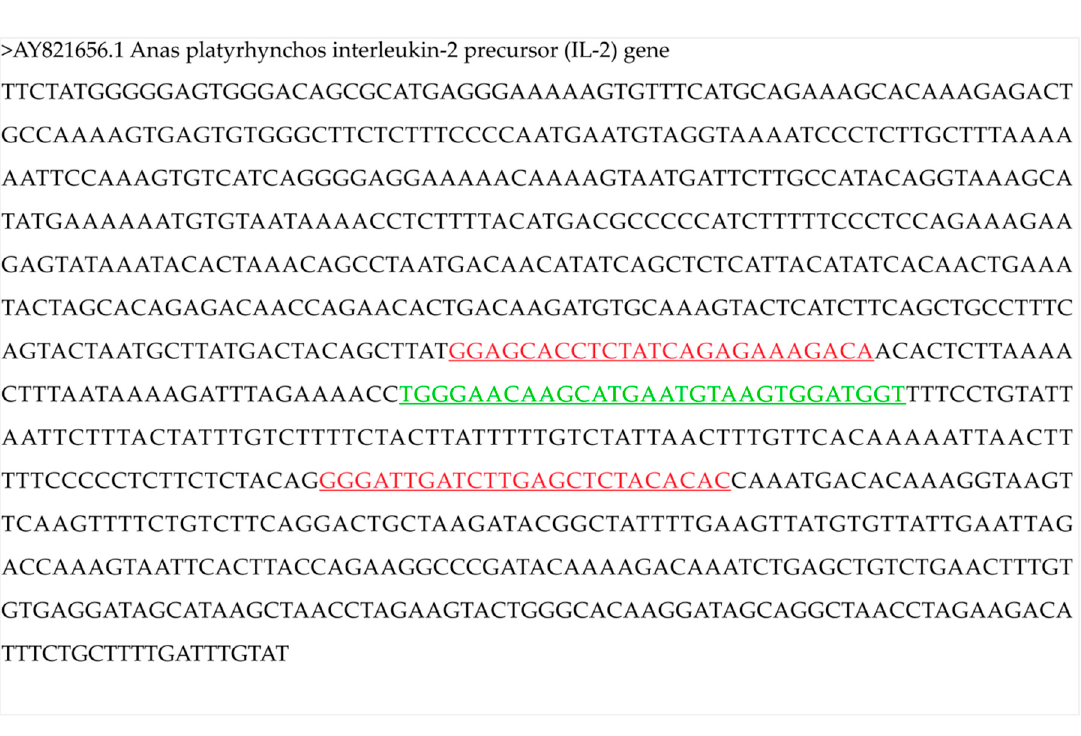
Figure 1. Sequence of the interleukin 2 precursor gene (AY821656.1). The primers (red) and probe (green) for the digital PCR are underlined. The amplicon size was 212 bp.